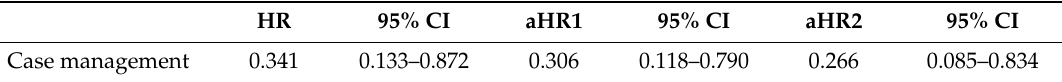
Figure 3. Survival curves by case management program. CM: Case management. Table 3. Results of Cox regression analysis for death by suicide.